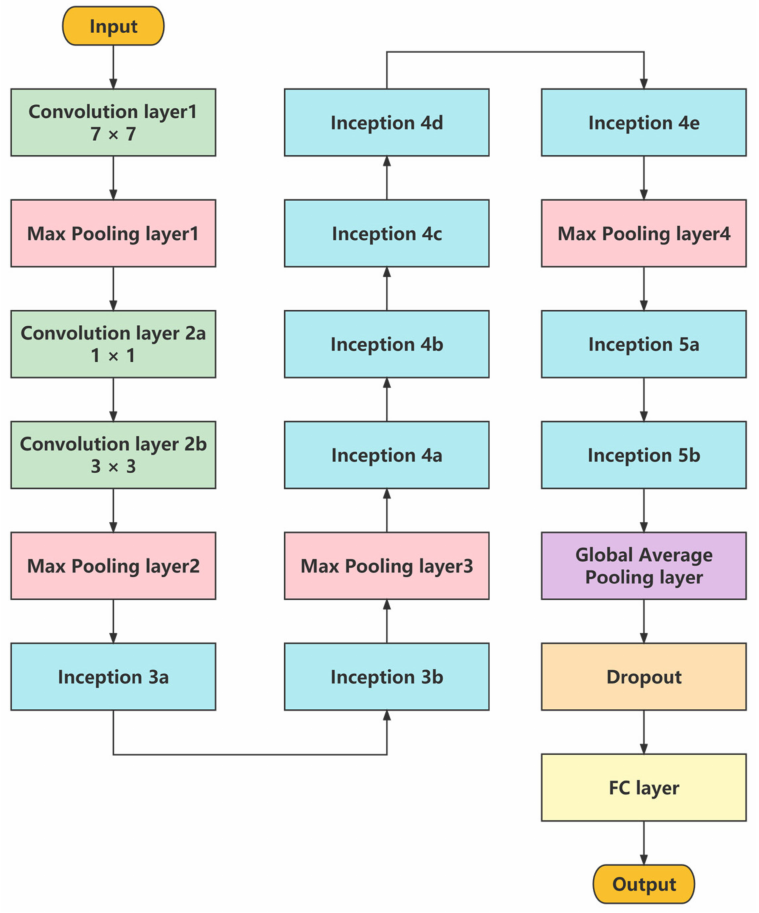
Figure 7. GoogLeNet model structure diagram.